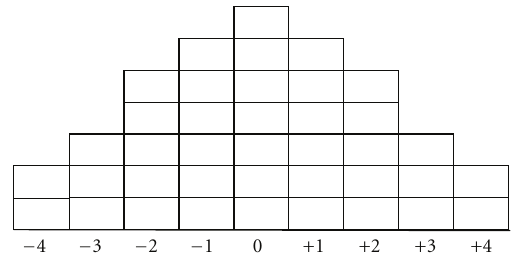
Figure 1: Blank Q-sort grid showing rank orderings from − 4 (most unlike my own experience) to +4 (most like my own